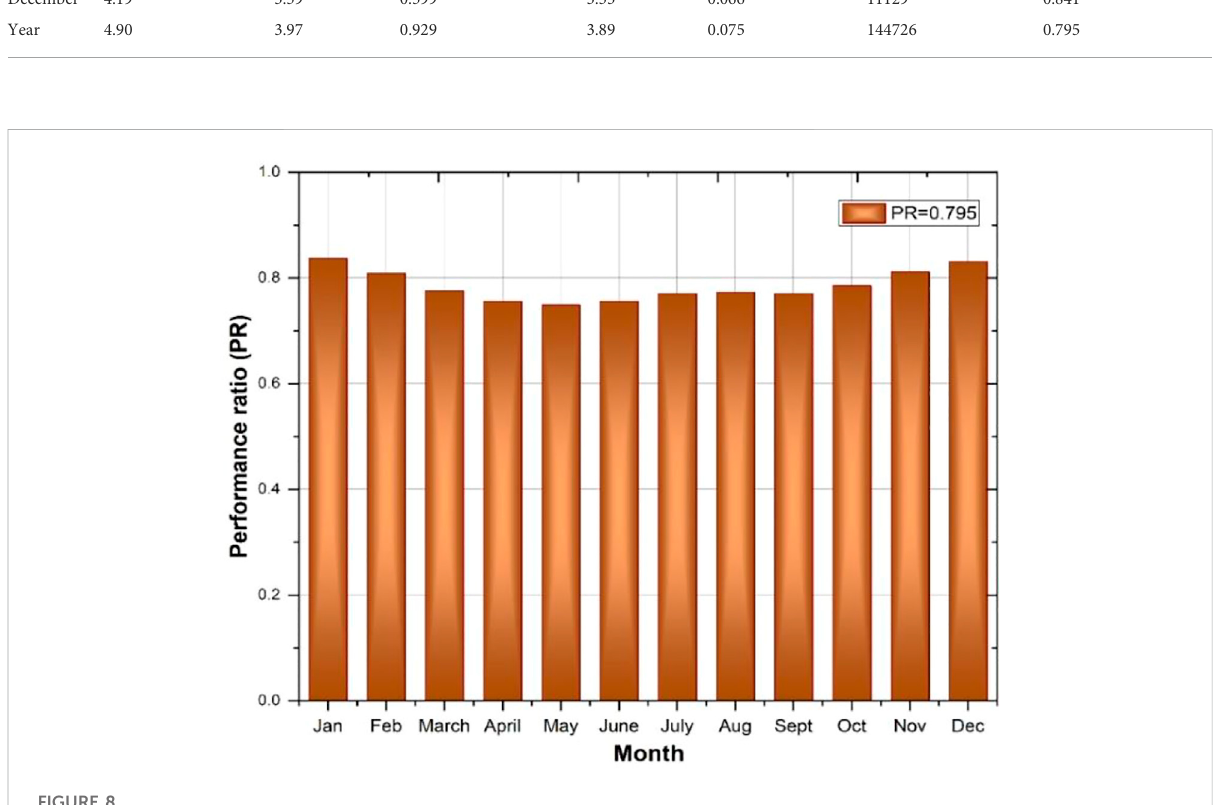
FIGURE 8 Overall performance